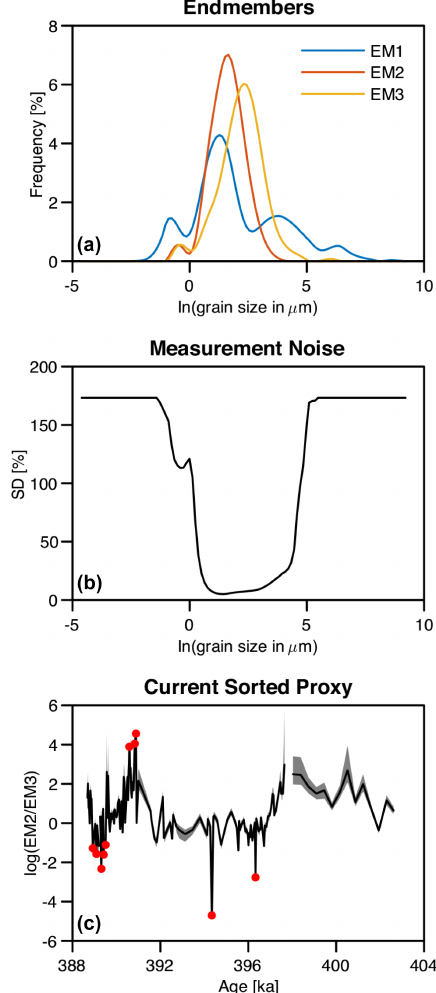
Figure 3. Fitted endmembers and data noise model for the current sorted proxy for DSDP 610B. (a) Grain size distributions for the three fitted endmembers. (b) Estimated noise model for the grain size measurements. (c) The current sorted proxy (ln(EM2 / EM3)). The grey-shaded area indicates the 95% confidence interval. Red dots denote where the confidence interval is undefined due to low abundances of EM2 and/or